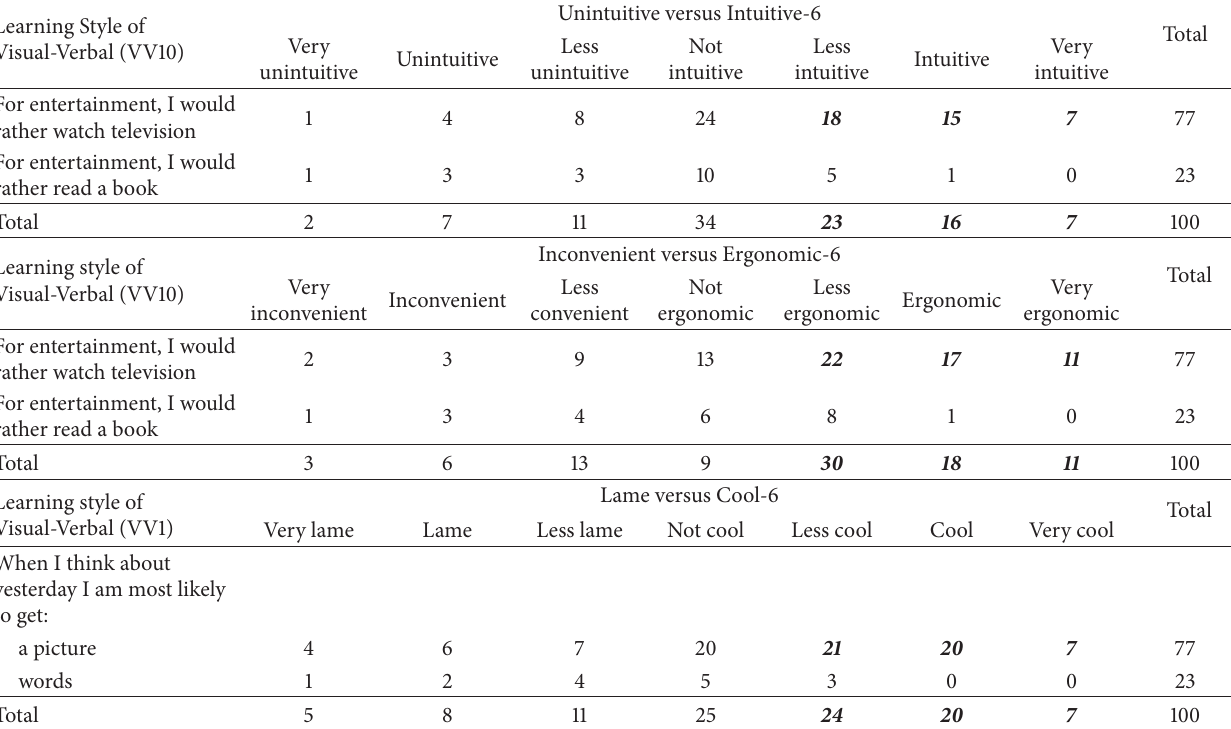
Table 18: The Interpretation of Design no. 6 versus the the students preferences related to entertainment (VV10) and the memorization (VV1). (Based on kansei words Unintuitive-Intuitive, Inconvenient-Ergonomic, and